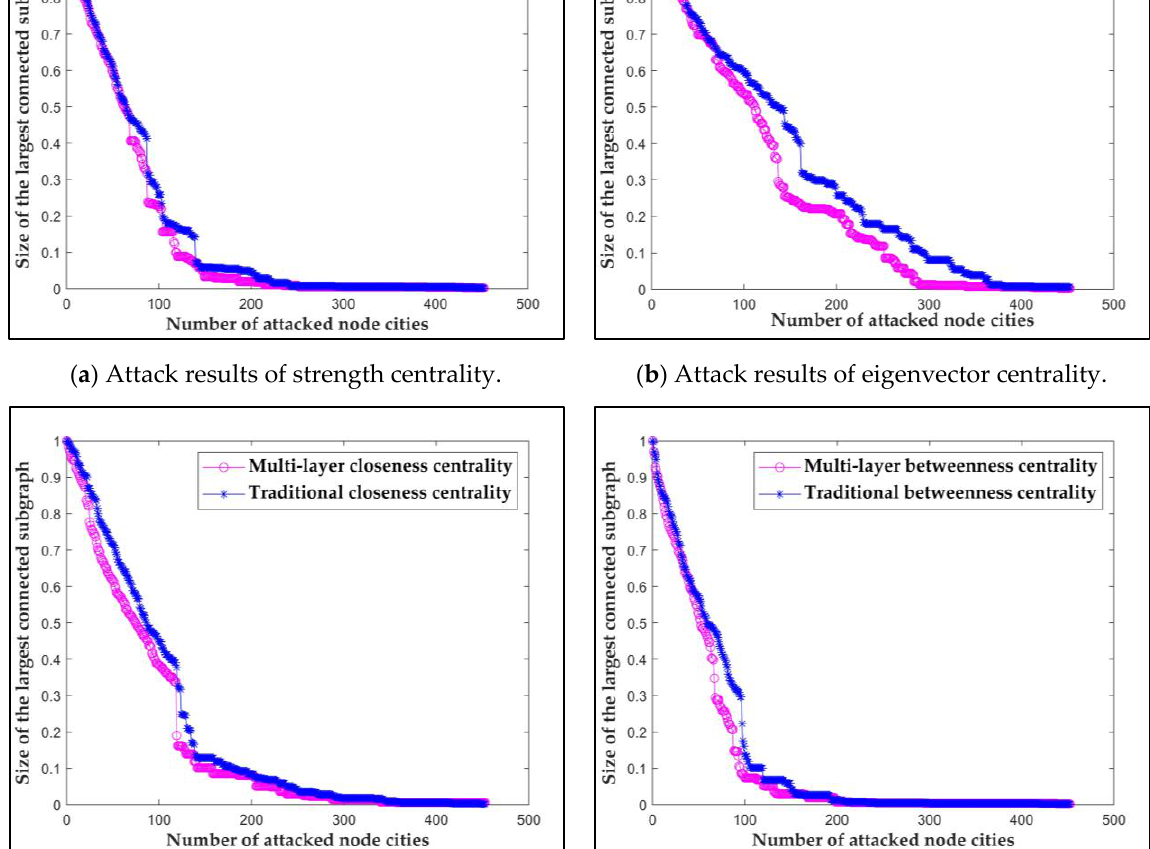
Figure 8. Attack results of multi-layer centrality and traditional centrality.